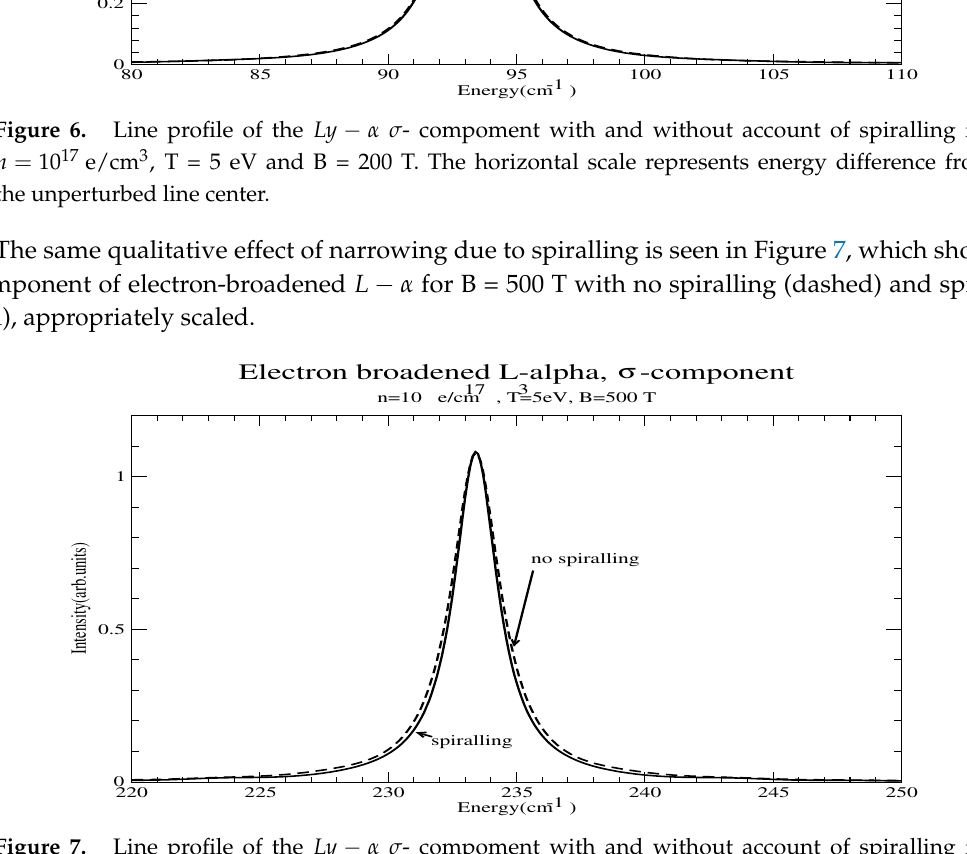
Figure 7. Line profile of the Ly − α σ - compoment with and without account of spiralling for n = 10 17 e/cm 3 , T = 5 eV and B = 500 T. The horizontal scale represents energy difference from the unperturbed line